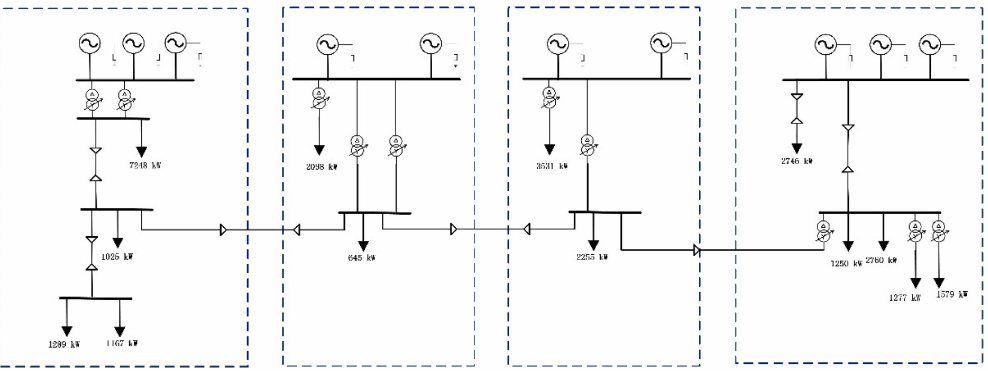
Figure 7. Schematic diagram of a certain power